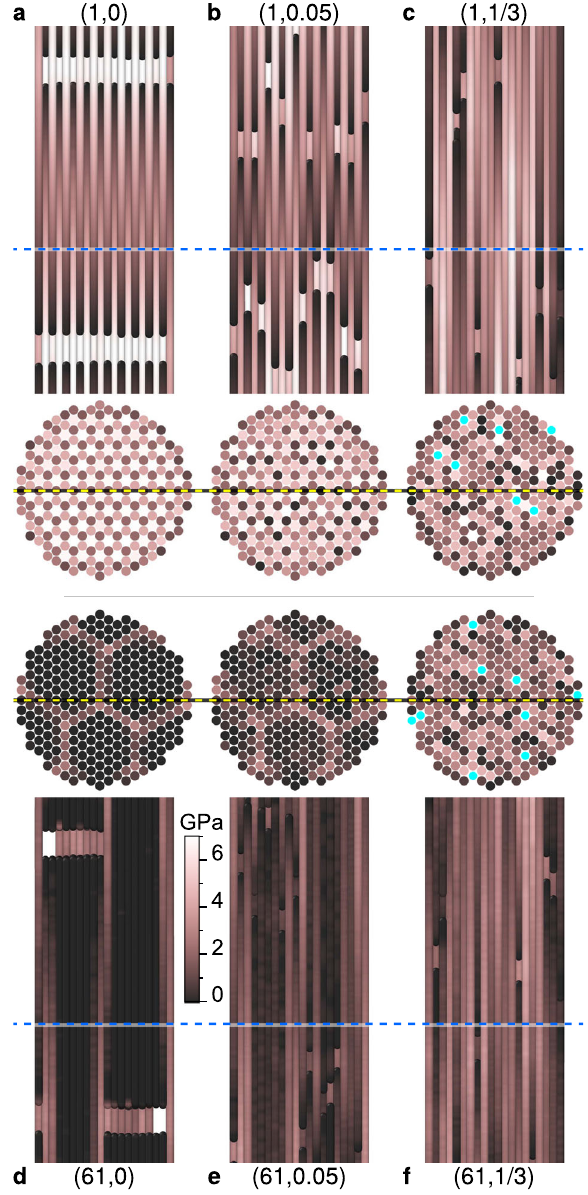
Fig. 4 Simulated stress tomography of a fi nite-width fi ber. Longitudinal and transverse cross-sectional view of the fi nite- width fi ber showing stress distribution during tensile loading simulations right before critical failure for select combinations of ( n , ζ ) as indicated by the corresponding numerical values. For each in ( a – f ), the dashed lines indicate the position of the respective cross section. The cyan fi lled circles represent gaps/holes in the fi ber cross